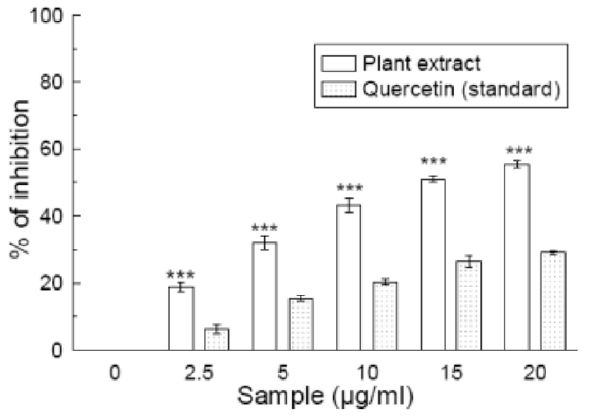
on superoxide radical. The data represent the percentage superoxide radical inhibition. All data are expressed as mean